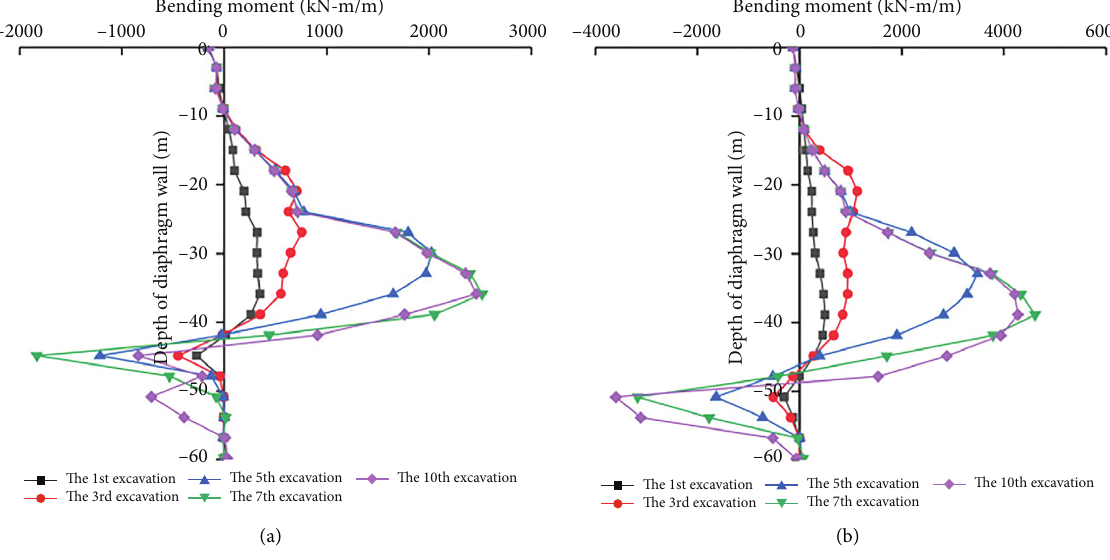
Figure 11: The bending moment curve of the diaphragm wall. (a) West wall. (b) East wall.